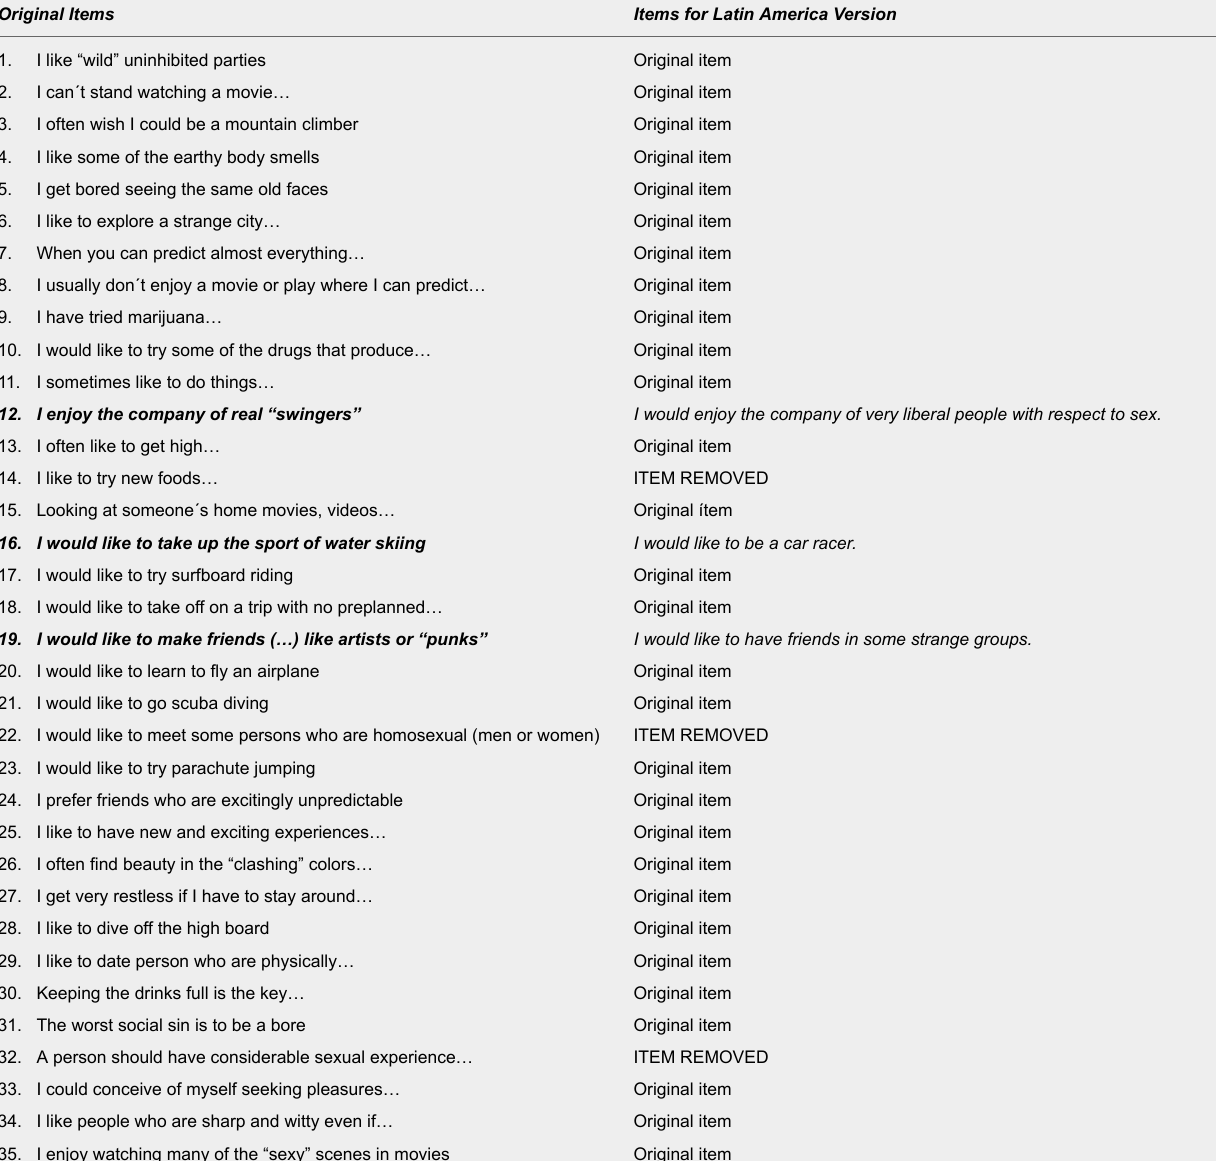
Linguistic and Conceptual Adaptation (Items Modified, Removed and New